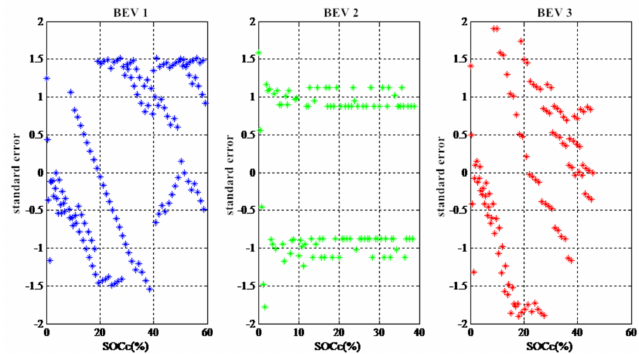
Figure 8. Standard error of charging time